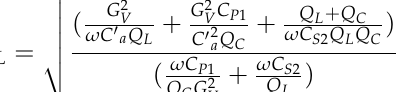
Figure 14 illustrates the system efficiency curves against the variations of load re- sistance for four SP compensation topologies. The output voltages of the four topologies are designed to be the same. The voltage gains of CLLC and LCCL are 0.2 and 5, respec- tively. It can be seen that the system efficiency of CLLC topology is the highest among the load variations, which is due to the CLLC topology in CV mode equivalent to the buck converter, leading to the smallest loop current under the same power level. Each compen- sation topology has an optimum load resistance to achieve the highest system efficiency. The optimum load resistance can be adjusted according to the application requirements.